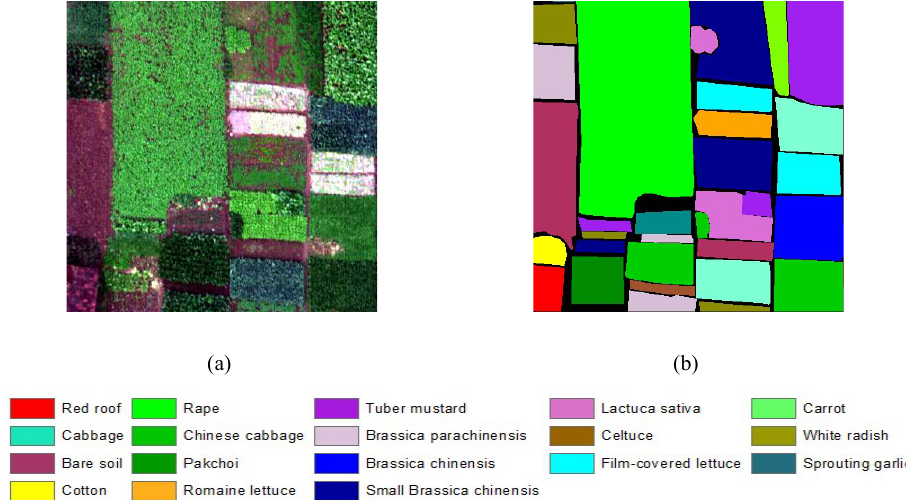
Figure 7. The Honghu dataset: ( a ) The true-color image; ( b ) the ground-truth map.